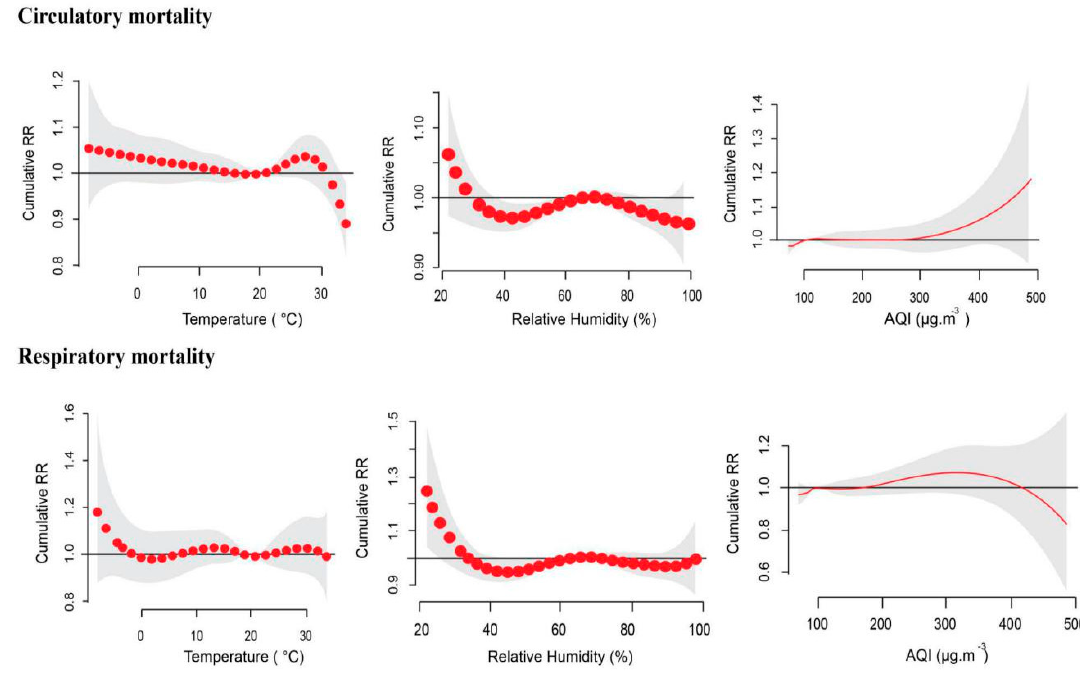
Figure 2. The cumulative effect of climatic parameters (temperature (°C), relative humidity (%), and AQI ( μ g·m − 3 ) in relation to mortality (circulatory and respiratory).